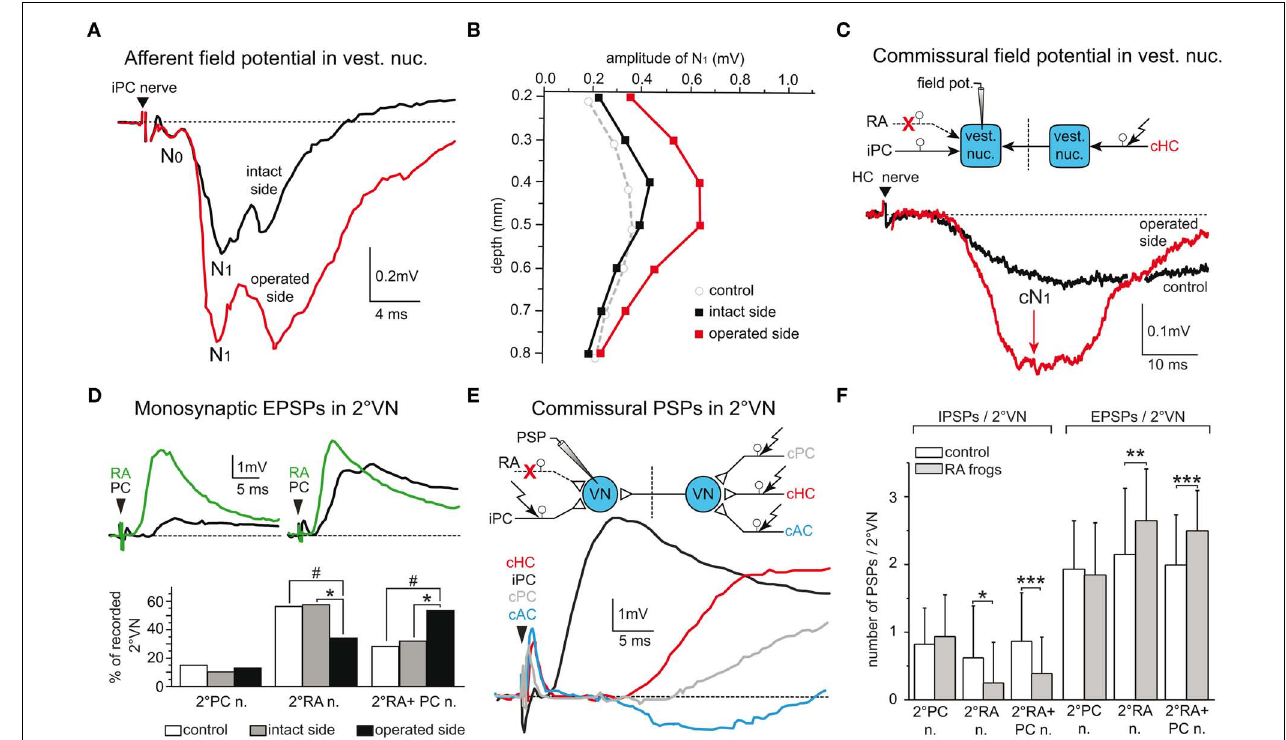
2˚PC neurons on the operated side of chronic RA frogs are complementarily altered, with respect to the pattern on the intact side (* P ≤ 0.01) or controls ( # P ≤ 0.0001); data adopted from Goto et al. (2000). (E,F) Plasticity of commissural semicircular canal inputs in 2˚VN of chronic RA frogs; typical afferent and commissural responses of a 2˚PC neuron (E) ; the pattern consists of an afferent (i) PC nerve-evoked monosynaptic EPSP and commissural (c) anterior vertical canal (AC) nerve-evoked IPSP, cHC, and cPC nerve-evoked EPSPs; ipsi- and contralateral stimulation and recording sites are illustrated (scheme); the relative proportions of IPSPs/2˚VN and EPSPs/2˚VN (F) in chronic RA frogs (gray bars) are significantly altered (* P ≤ 0.01, ** P ≤ 0.001, *** P ≤ 0.0001) in a complementary fashion on the operated side in 2˚RA and 2˚RA + PC but not in 2˚PC neurons compared to controls (white bars); data adopted from Goto et al.